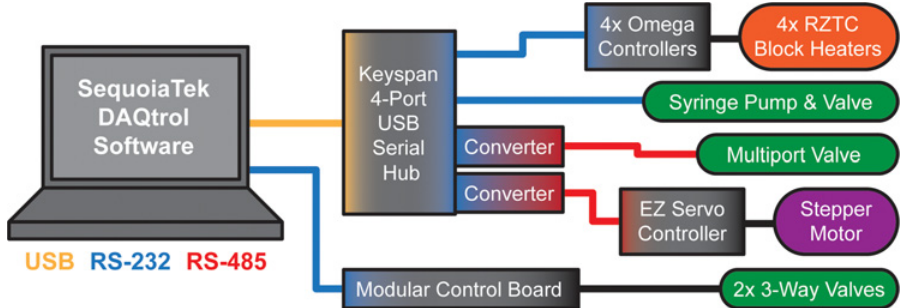
Fig 6. rzPCR system communication and hardware control architecture. A laptop-based DAQtrol graphical user interface (S3 Fig.) provides control and automation of the rzPCR system via pre-programmed scripts or manual control over pump, valve, heater, and data-logger